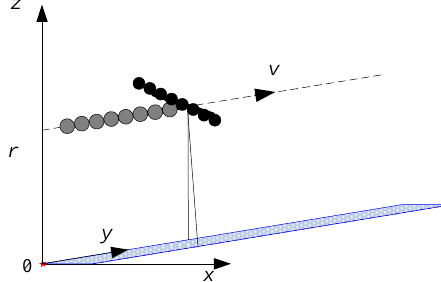
Figure 1. Geometry of the presented sub-bottom profiler.